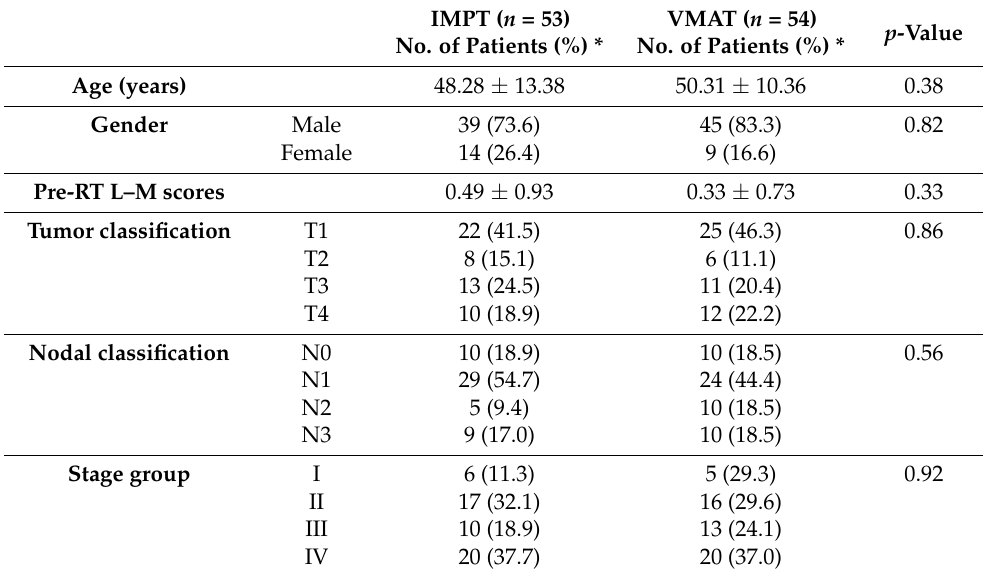
Table 1. Patients and tumor